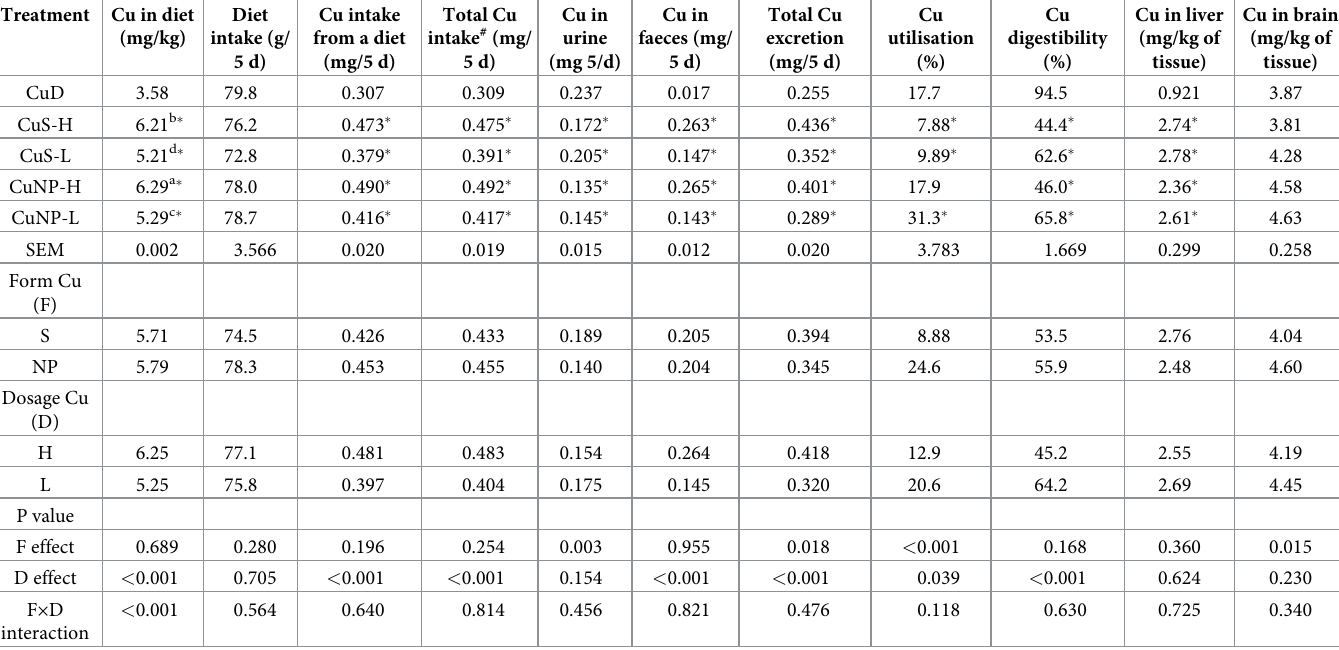
Table 4. Copper excretion patterns in the digestibility and utilisation test as well as Cu concentration in liver and brain tissues. Treatment Cu in diet